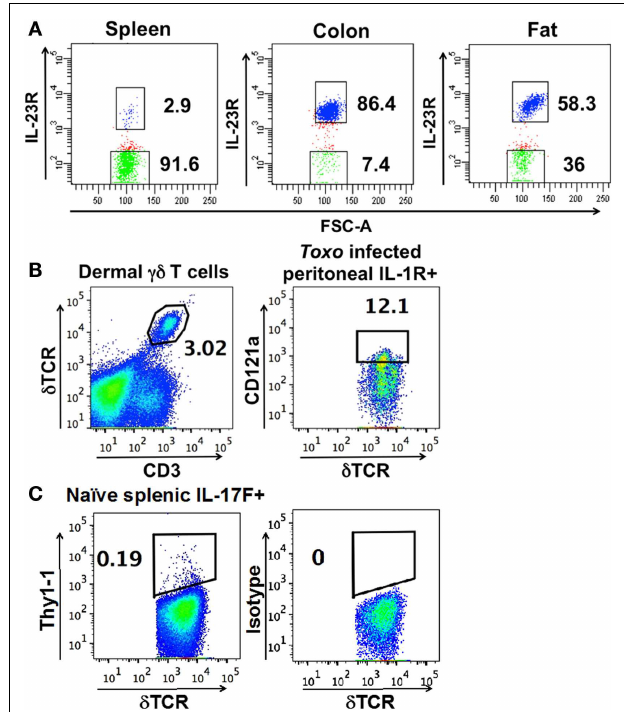
FIGURE 1 | Representative FACS analysis and gates used to isolate (A) IL-23R + (in blue) and IL-23R − γδ T cells (in green) (using FACSDiva) from IL-23R reporter mice . (B) Dermal cells, IL-1R + γδ T cells from the peritoneum of C57BL/6 mice infected with T. gondii 5h prior. (C) Thy1.1 + cells from the spleen of naïve IL-17F reporter mice. (B,C) are plotted using FlowJo.The number within each graph indicates the percentage of the designated population of cells out of the total γδ T